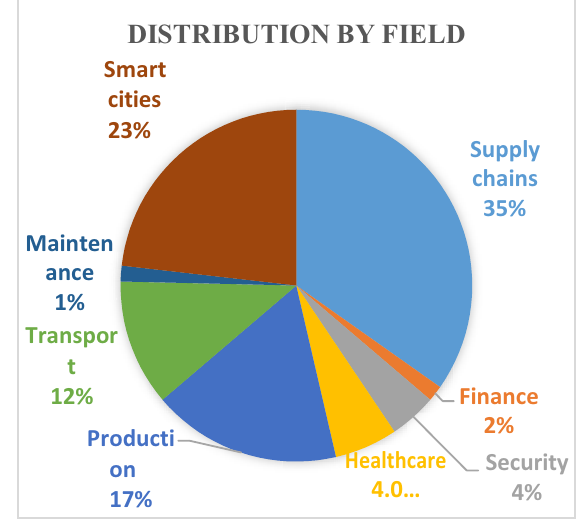
Fig 4. Distribution by